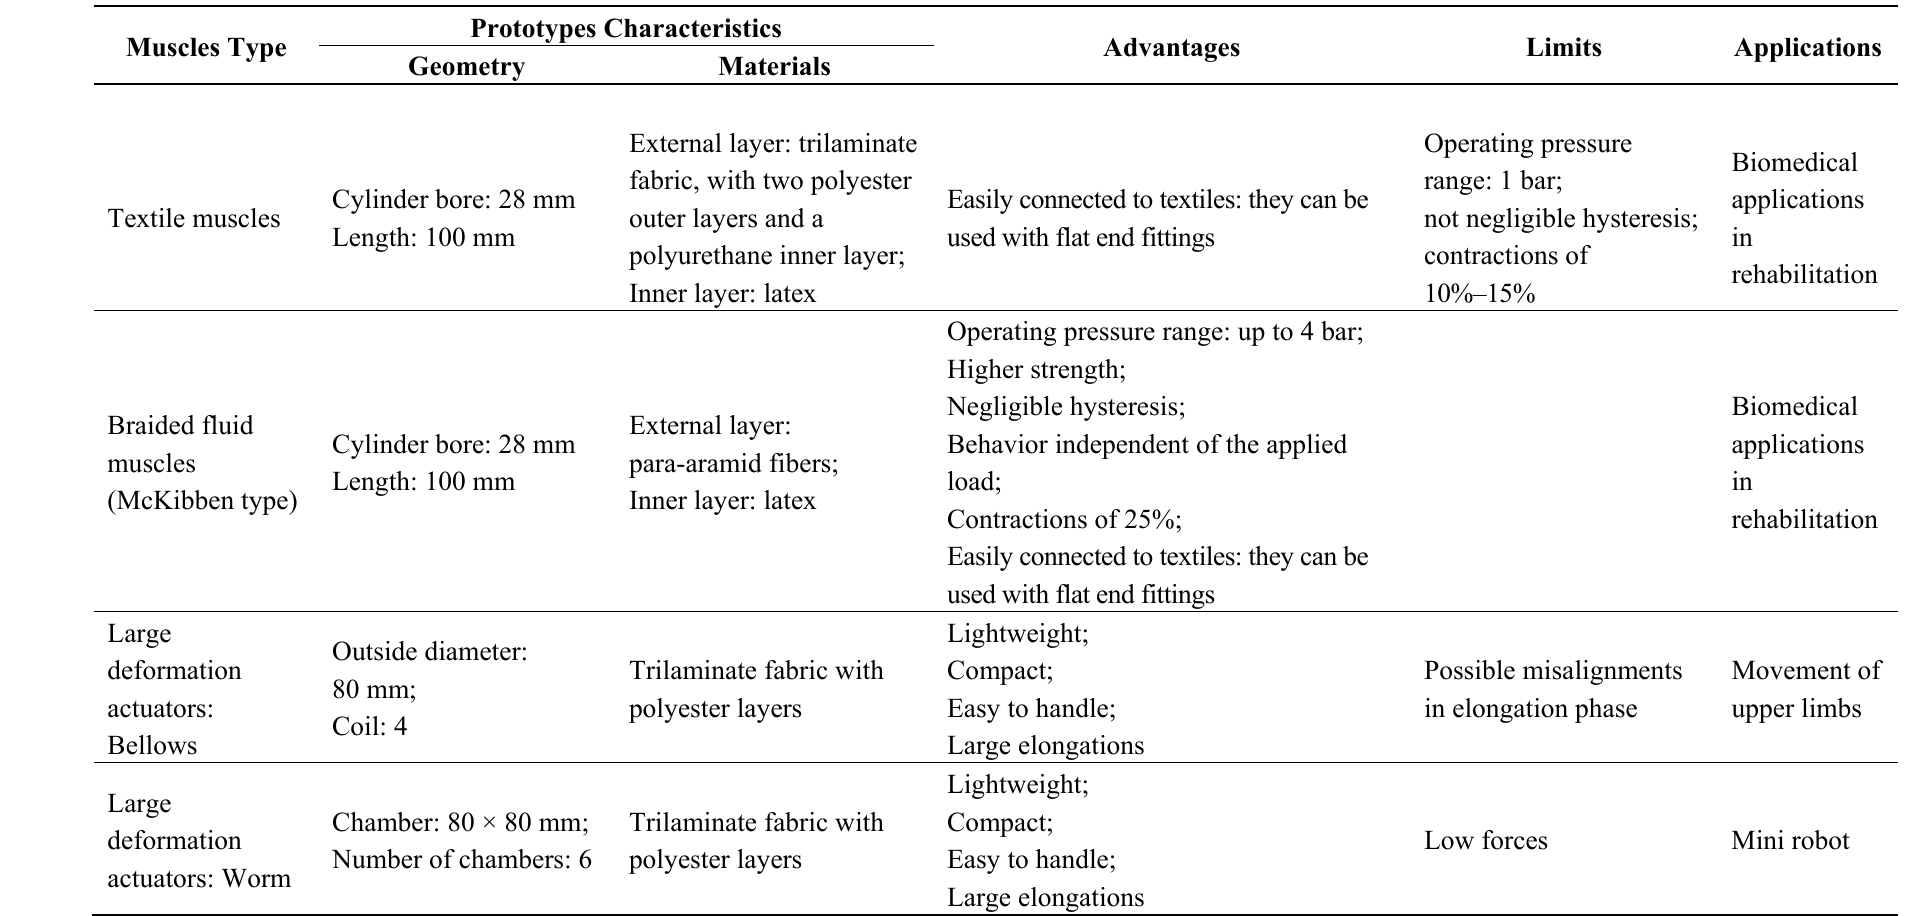
Table 1. Main features of the pneumatic muscles